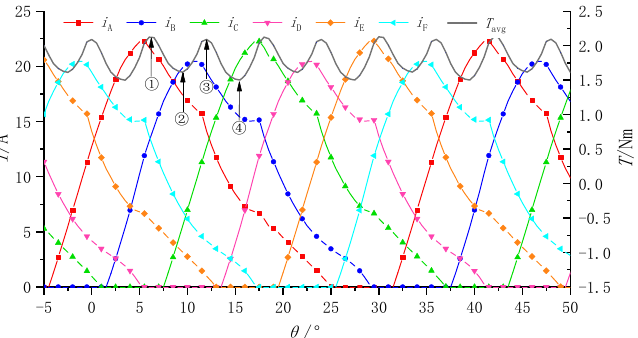
Figure 2. Current and torque waveforms of the investigated six-phase SRM under NNSS alternative winding connection.